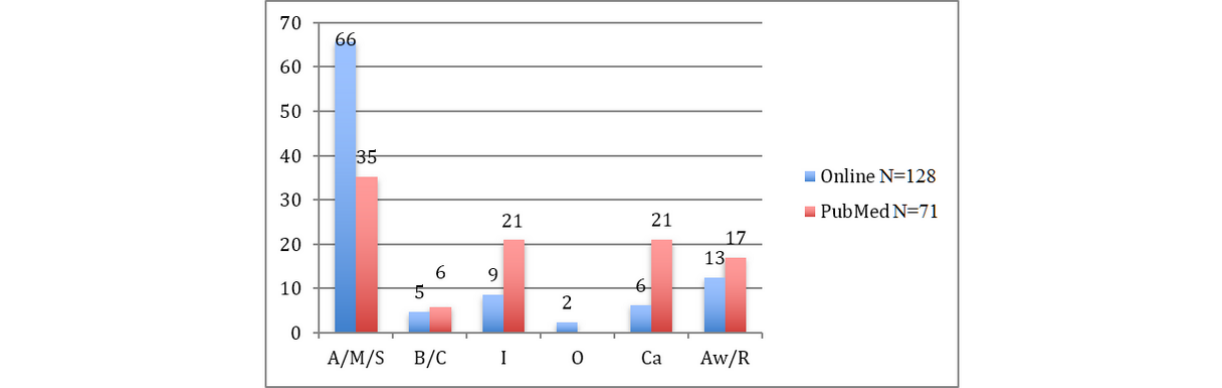
Figure 3. Percentage of casualties for each cause of death in dental facilities using data from online publications and PubMed. Possible duplicates were not excluded. A/M/S: anesthesia, medication, or sedation; B/C: bleeding or coagulation; I: infection; O: others; Ca: cardiovascular system; Aw/R: airway or respiratory system.